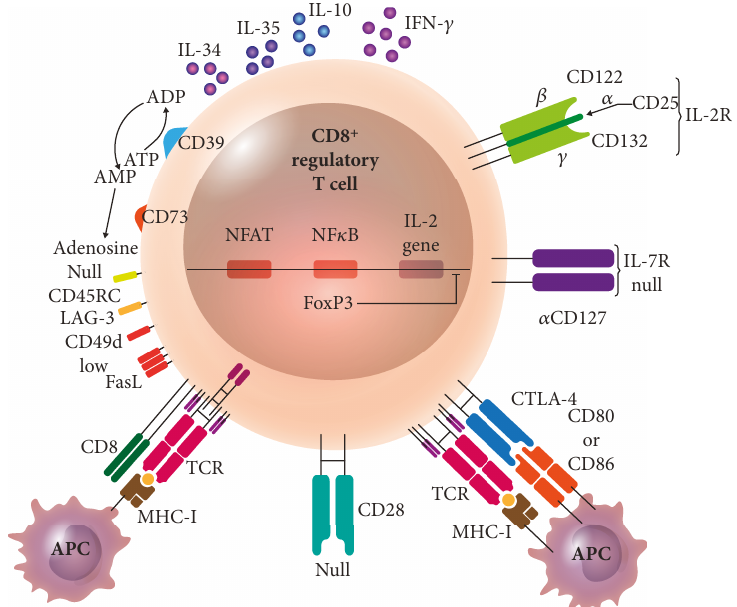
Figure 1: CD8 + Treg lymphocyte. CD8 + Treg lymphocytes have di ff erent suppression mechanisms of cell activation and survival, using their own molecule expression: IL-2 receptor α -chain (CD25), IL-2 and IL-15 receptor β -chains (CD122), inhibitory receptor CD152 or CTLA-4, ectoenzymes CD39 and CD73 degrading ATP to ADP (CD39) and AMP to adenosine (CD73), an MHC-II-binding molecule called LAG-3 (lymphocyte activation gene-3), and the apoptosis-inducing molecule FasL. This T cell subset expresses low or absent costimulatory receptor CD28 and the IL-7 receptor α -chain (CD127), the cellular activation molecule CD45RC, and the integrin CD49d and releases cytokines as IL-10, IL-34, IL35, and IFN- γ ; transcription factor FoxP3 inhibits IL-2 gene transcription. APC: antigen-presenting cell; CTLA-4: cytotoxic T-lymphocyte antigen CD8 + Treg lymphocytes: (a) direct death of target cell [5, 6], (b) negative signaling through CTLA-4 or PD1 when